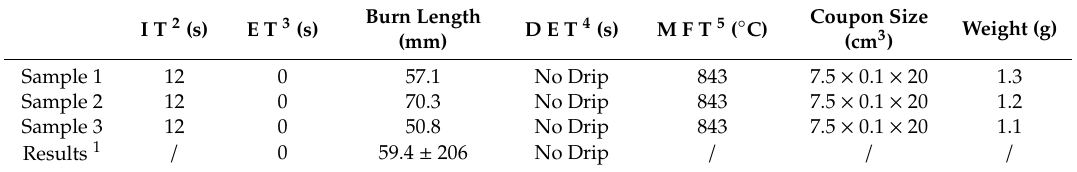
Table 2. Vertical Bunsen Burner Test for Cabin and Cargo Compartment Materials (Federal Aviation Regulation FAR 25.853 and FAR 25.855).